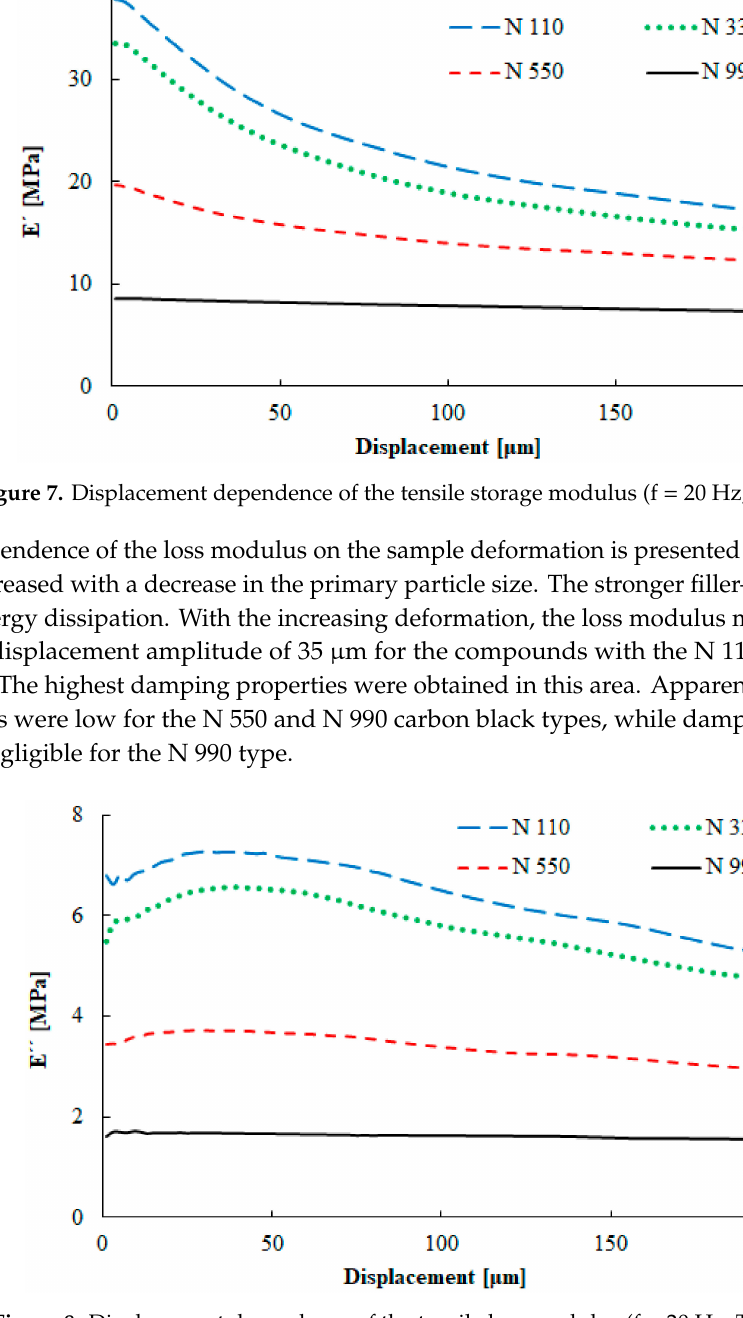
Figure 8. Displacement dependence of the tensile loss modulus (f = 20 Hz, T = 0 ◦